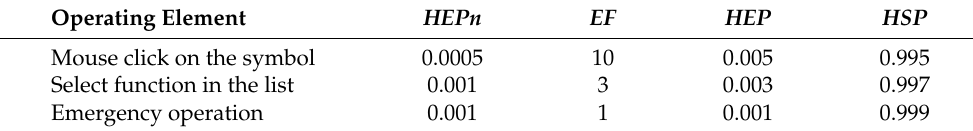
Table 12. Summary of HEP s, HSP s of operated elements (workplace